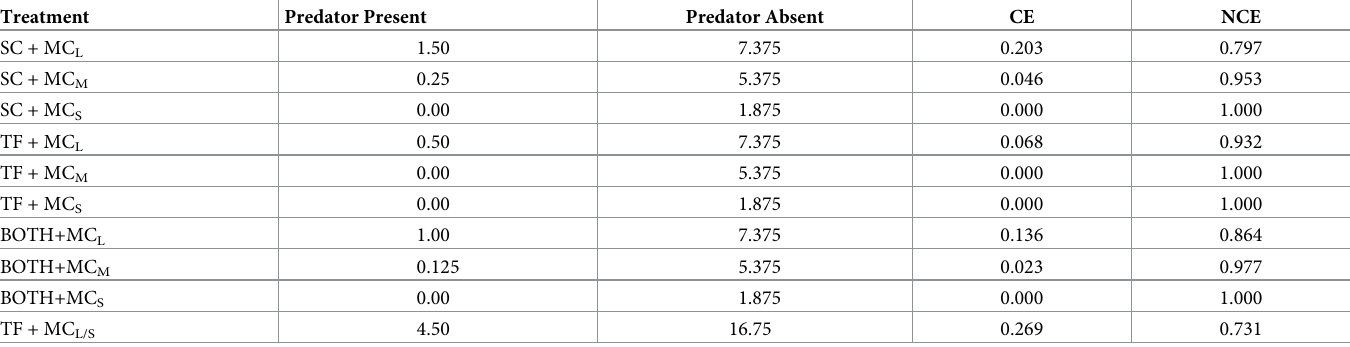
Table 4. Consumptive effects (CE) and non-consumptive effects (NCE = 1 –CE) for caged predator TMII experiments. Predator present vs. predator absent values represent numbers of 15 mm oysters consumed during the experiments (out of 10 possible except for the mixed size treatment, which used 20 oysters).